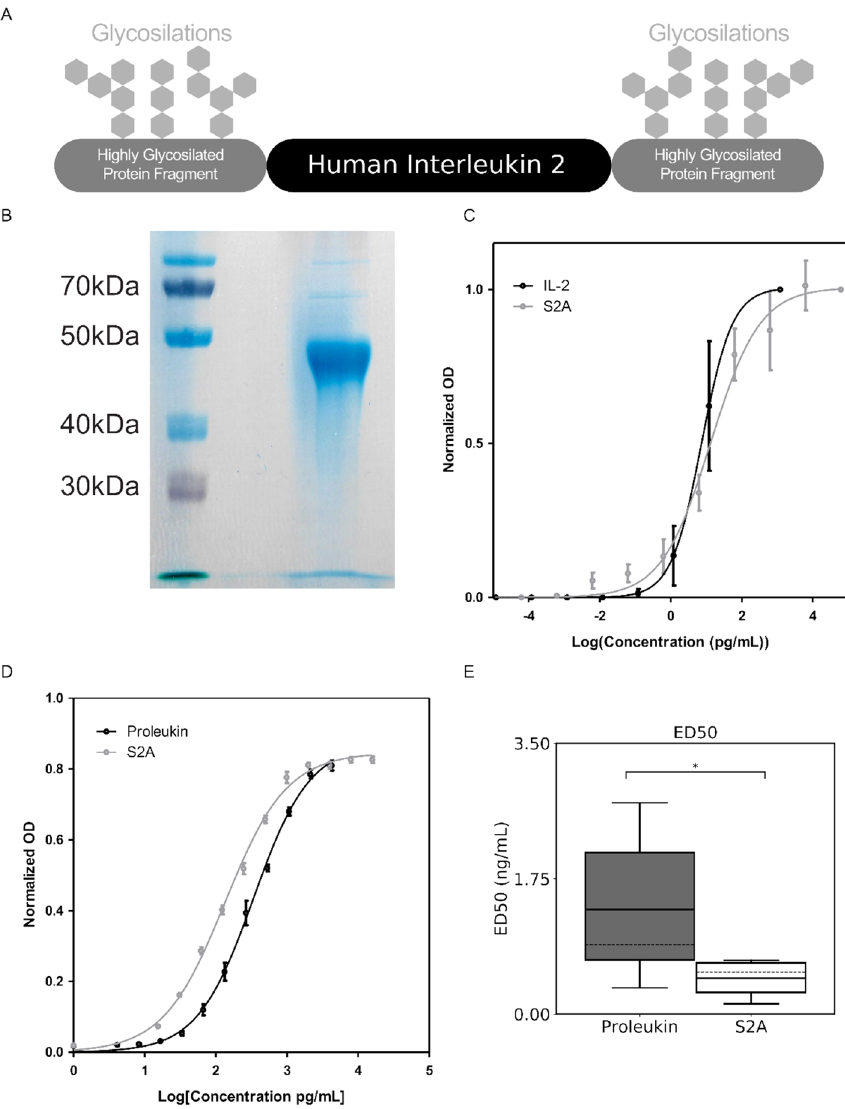
Figure 1. IL-2 variant design and in vitro functional analysis. ( A ) A scheme structure of the recombinant IL-2 S2A. The human IL-2 encoding sequence is flanked by two highly glycosylated fragments. S2A sequence also includes the IL-2 signal peptide at the N-terminal and His-tag sequence at the C-terminal. ( B ) S2A encoding plasmids were transfected into HEK293F cells, and protein was purified from media using the Ni-ion exchange column. Following purification, purity and size were determined by running eluted fraction on SDS-PAGE. ( C ) A representative ELISA binding curve (fitted to 4-parameter logistic) using IL-2 ELISA kit (Biolegend) ( D ) A representative CTLL-2 proliferation test, done using MTT assay (fitted to 4-parameter logistic. ( E ) Aggregated results of 5 independent CTLL-2 assays for different preparations of commercial IL-2 (Proleukin) and S2A.